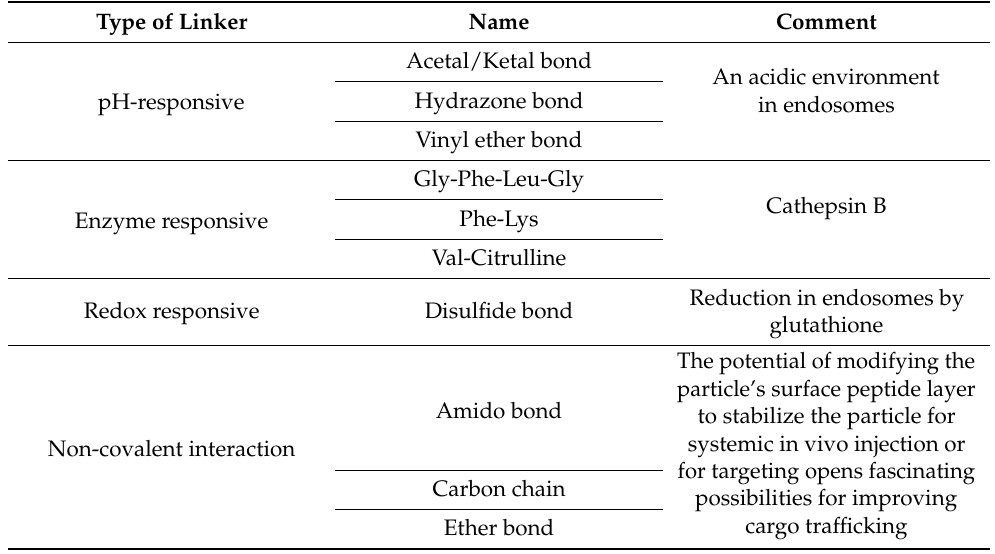
Table 3. Different types of linkers used in peptide-drug